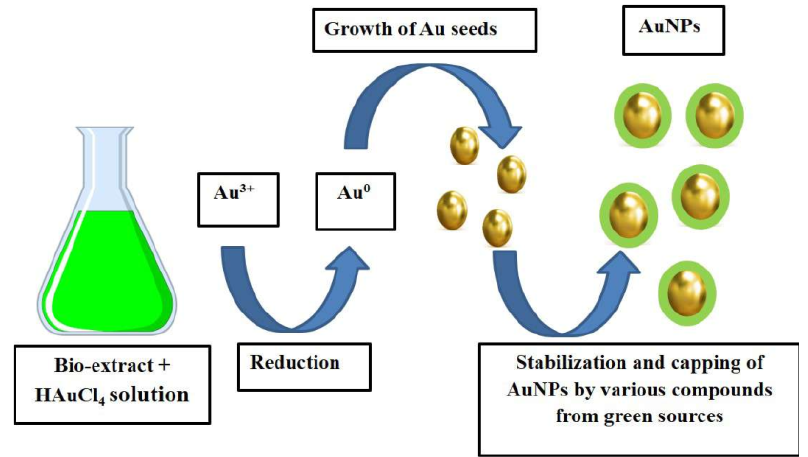
Figure 4. Schematic representation of AuNPs biosynthesis mechanism.